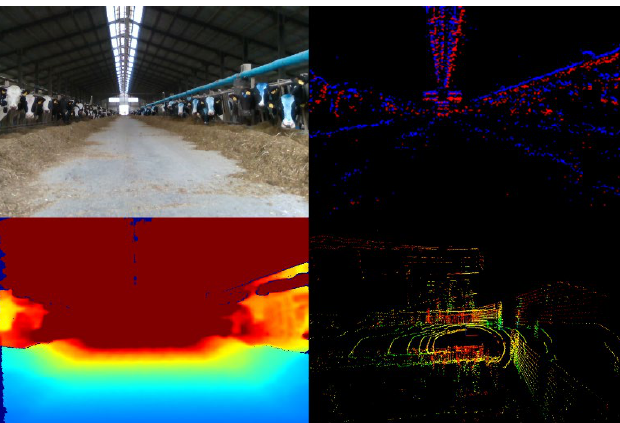
Fig. 1. Sample of RGB, DVS, Depth, and LIDAR data.